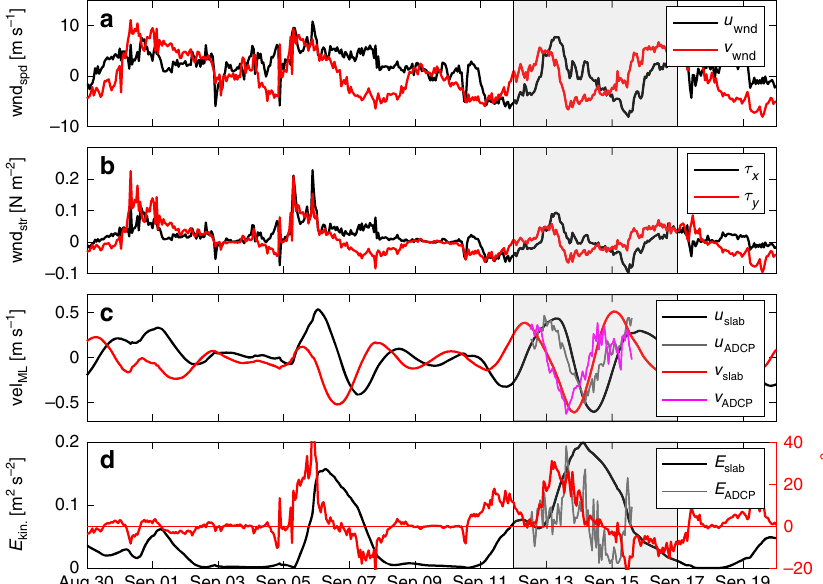
Fig. 5 Slab ocean response compared to observed velocities. a Zonal ( u wnd ) and meridional ( v wnd ) 4-m wind speed from the PIRATA buoy at 11.5°N, 23° W, and b the resulting zonal ( τ x ) and meridional ( τ y ) wind stress components. c Zonal ( u slab ) and meridional ( v slab ) mixed layer velocities as obtained from the slab model (thick black and red lines, respectively) compared to the zonal ( u ADCP ) and meridional ( v ADCP ) velocity observed at 17 m with the vessel- mounted acoustic Doppler current pro fi ler (vmADCP) during September 2015 (thin gray and magenta lines, respectively). d Total kinetic energy from the slab model and observed vmADCP velocities (thick black and gray lines, respectively) and wind power input (WPI, red). The latter had to be calculated with slab model velocities as the high temporal resolution of mixed layer currents from PIRATA is only available from November 2015. Gray shading in all panels indicates the time de fi ned for the NIW event also used in Fig. 7 for the instantaneous heat budget at the PIRATA